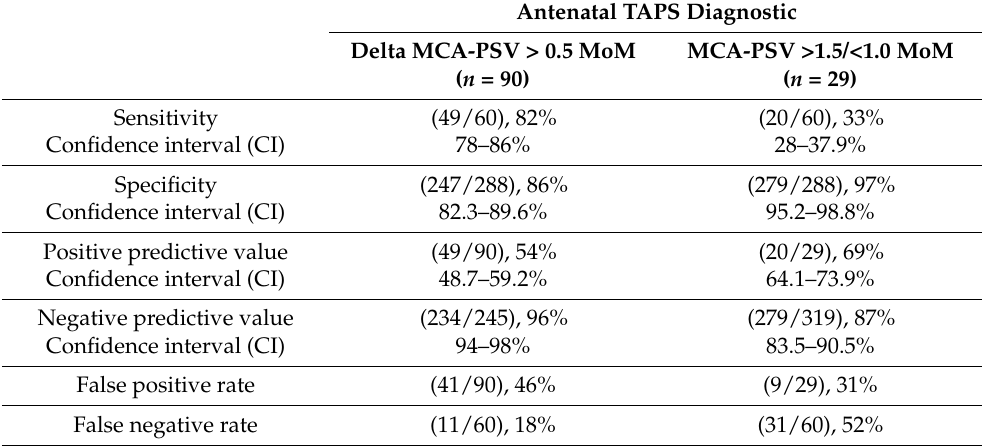
Table 2. Quality of antenatal diagnostic